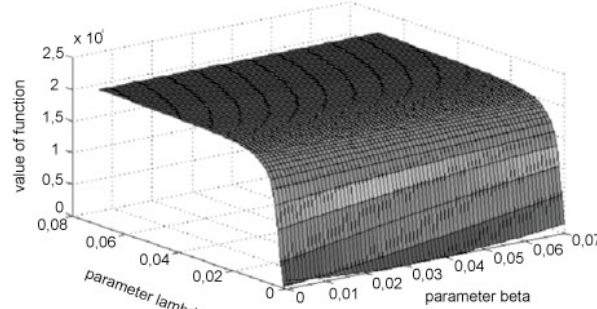
Fig. 8 – Function defined by the maximum verisimilitude criterion – 30